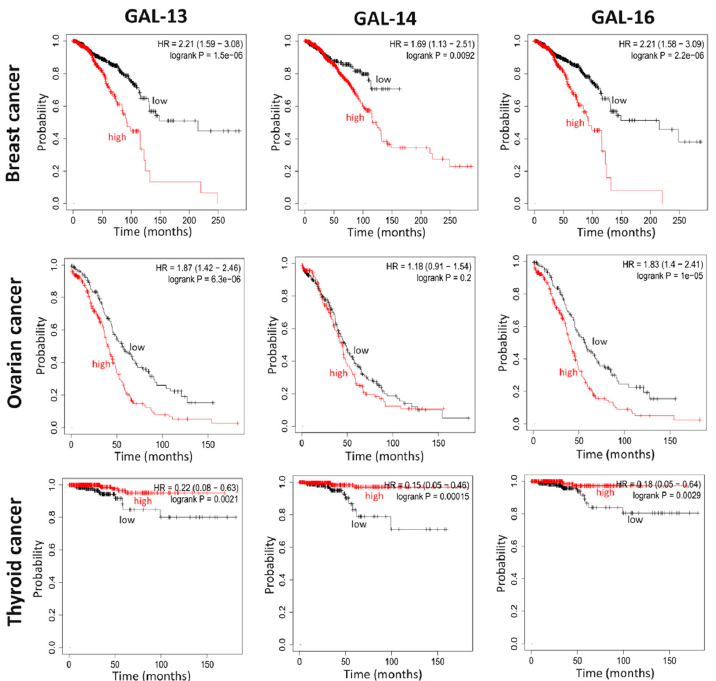
Figure 3. Kaplan ‒ Meier survival curves of patients according to placental galectin levels. Data were extracted from Nagy et al. Pancancer survival analysis of cancer hallmark genes was performed using data from 2021 [62]. The log-rank test was used to detect significant differences between sur- vival